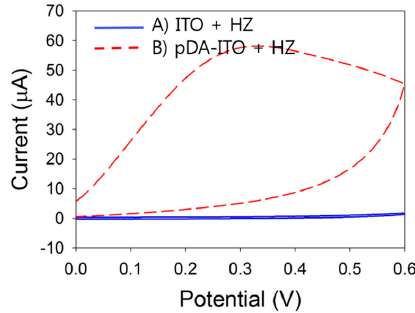
Figure 3. Cyclic voltammograms of 1 mM·HZ in Tris buffer with (A) an ITO electrode and (B) a pDA- ITO electrode at a scan rate 50 mV/s.